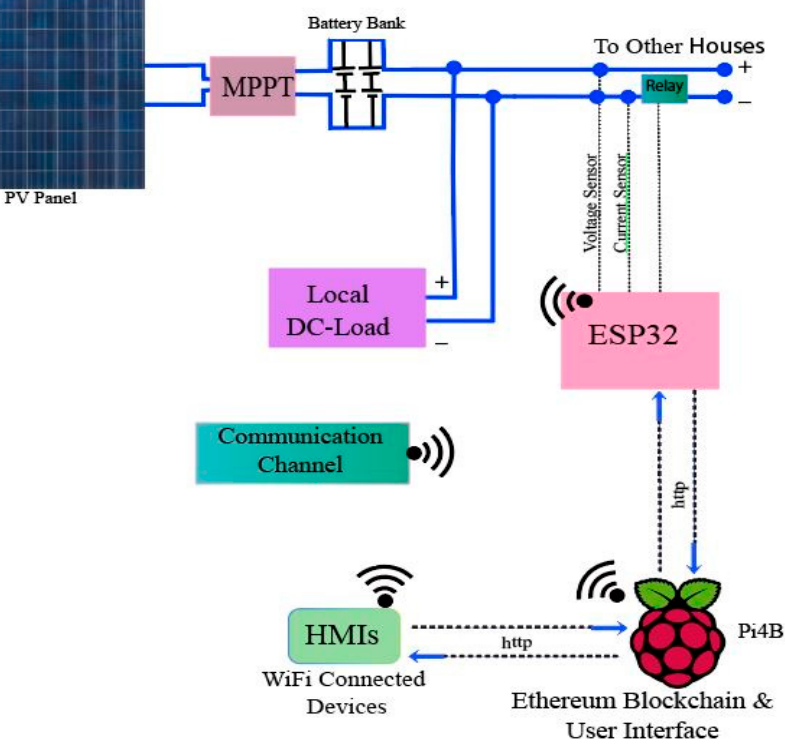
Figure 3. Proposed P2P energy trading system architecture .